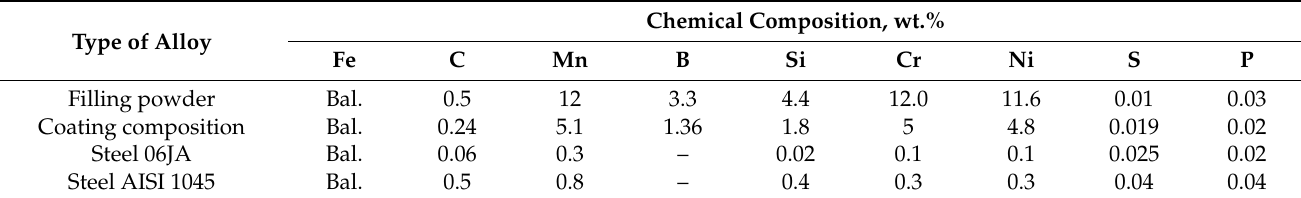
Table 1. Composition of materials used for this